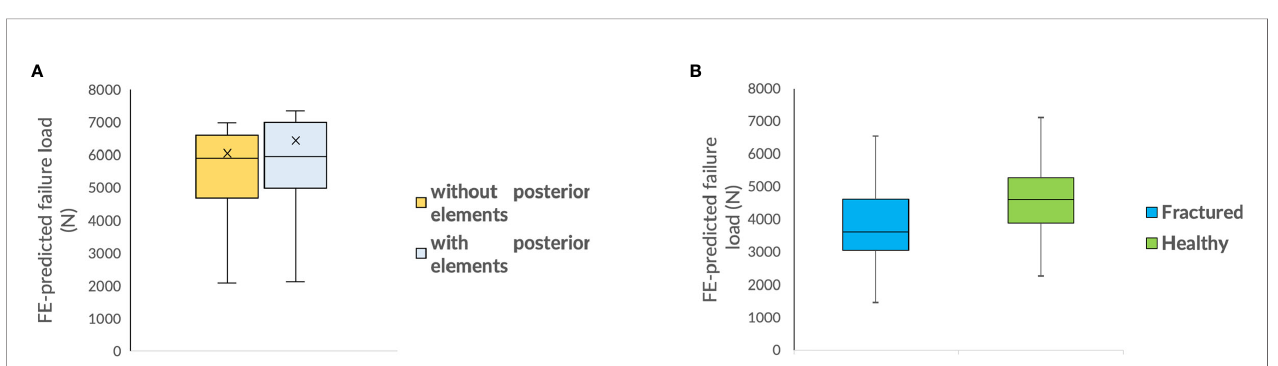
FIGURE 2 | (A) Box plot comparing FE-predicted failure load of a vertebra with and without posterior elements; (B) Box plot comparing FE-predicted failure loads of healthy and fractured cohort.